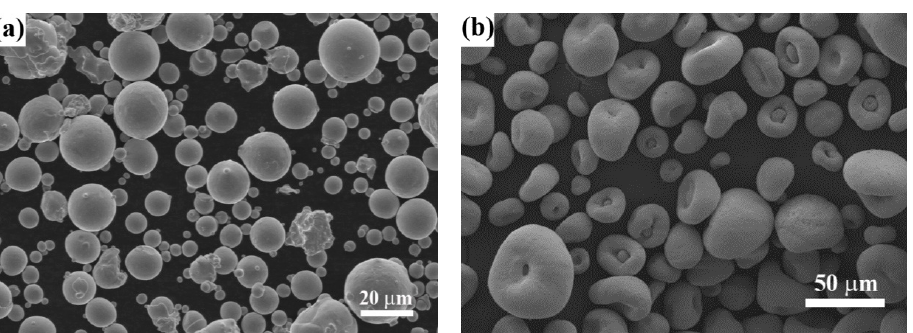
Figure 1. Morphologies of powders: ( a ) NiCrAlY used in bondcoat; ( b ) CYSZ used in topcoat.